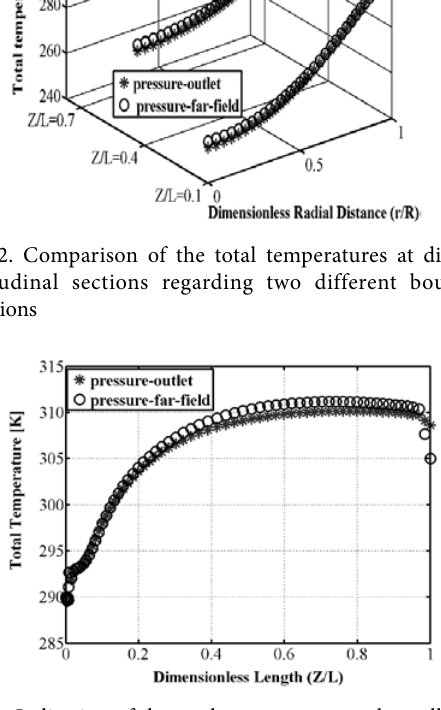
Fig. 13. Indication of the total temperature on the wall of the main tube for two different boundary conditions Figure 13 indicates the variation of the total tem- perature on the wall of the tube for both boundary con- ditions compared (Pressure-Far-Field and Pressure-Out- let). In this case there is also good agreement between both CFD